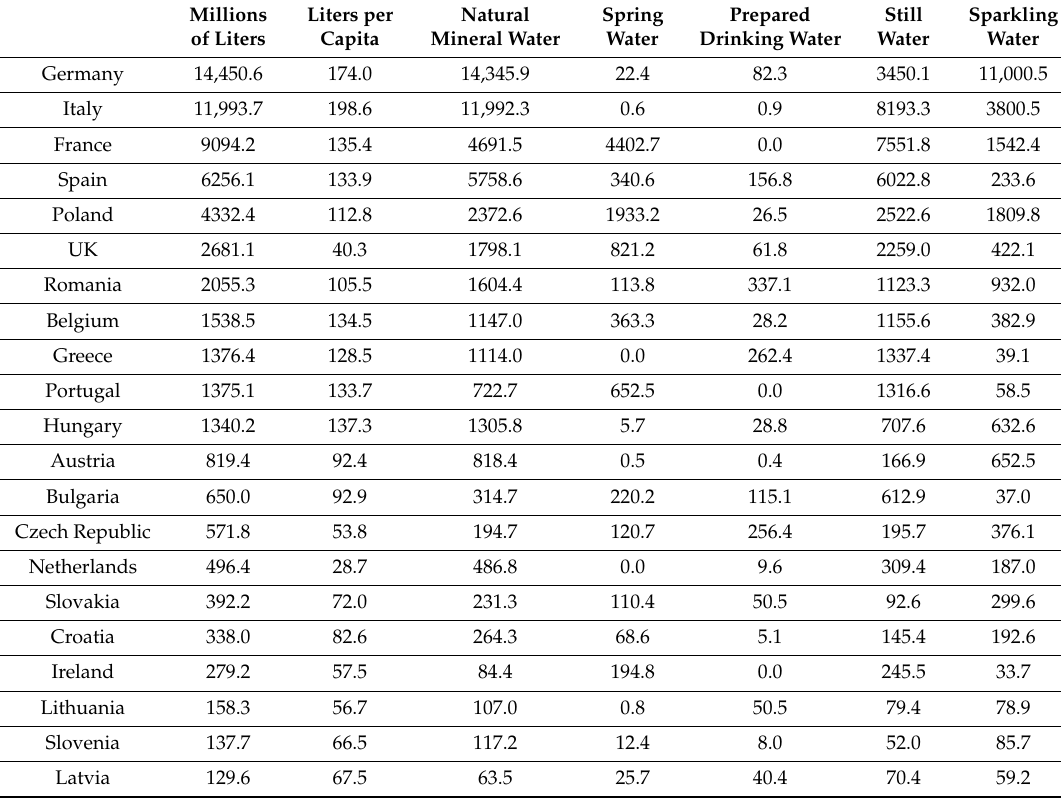
Table A2. Bottled water production and consumption per capita in European Union countries for the year 2018. Cyprus, Luxembourg and Malta do not package. Source: European Federation of Bottled Waters (https: //